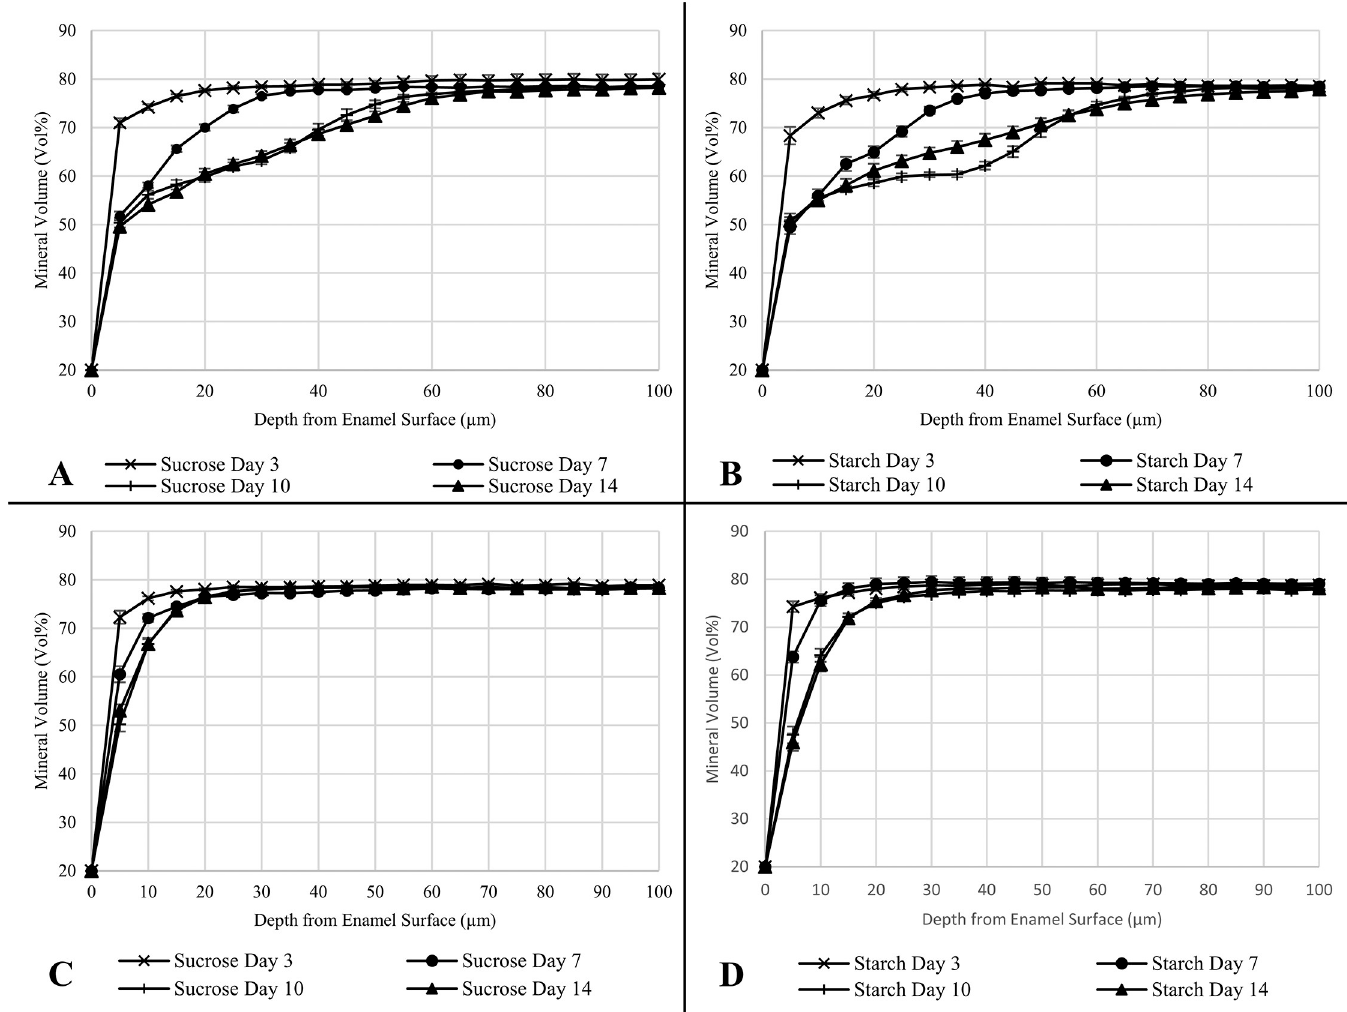
Fig 6. Enamel lesion profiles. Lesion profiles of bovine enamel discs exposed to either 2% sucrose or 2% starch over 14 days. ( A ) 2% Sucrose, No Fluoride. ( B ) 2% Starch, No Fluoride. ( C ) 2% Sucrose, 1450 ppm F-. ( D ) 2% Starch, 1450 ppm F-. The Lesion profiles show the change in mineral volume (Vol%) as distance from the enamel surface increases ( μ